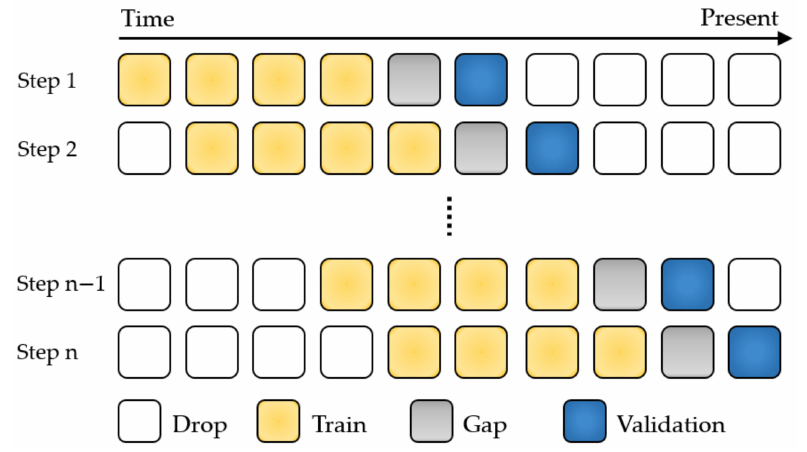
Figure 10. The sliding window-based time series validation